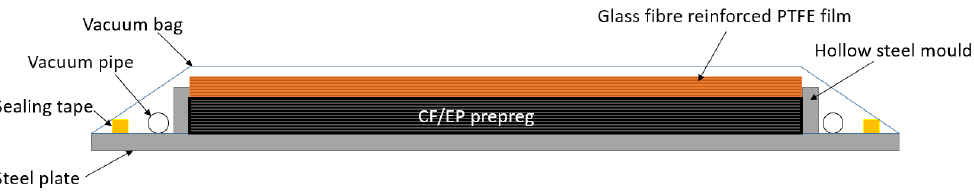
Figure 5. Schematic diagram of manufacturing set-up.